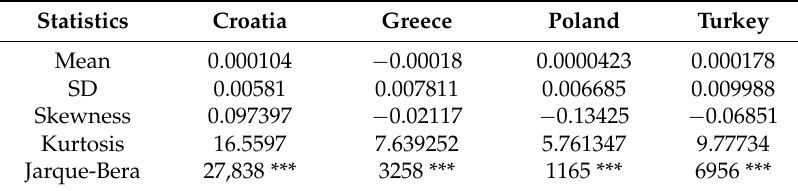
Table 2. Descriptive statistics of the original series.